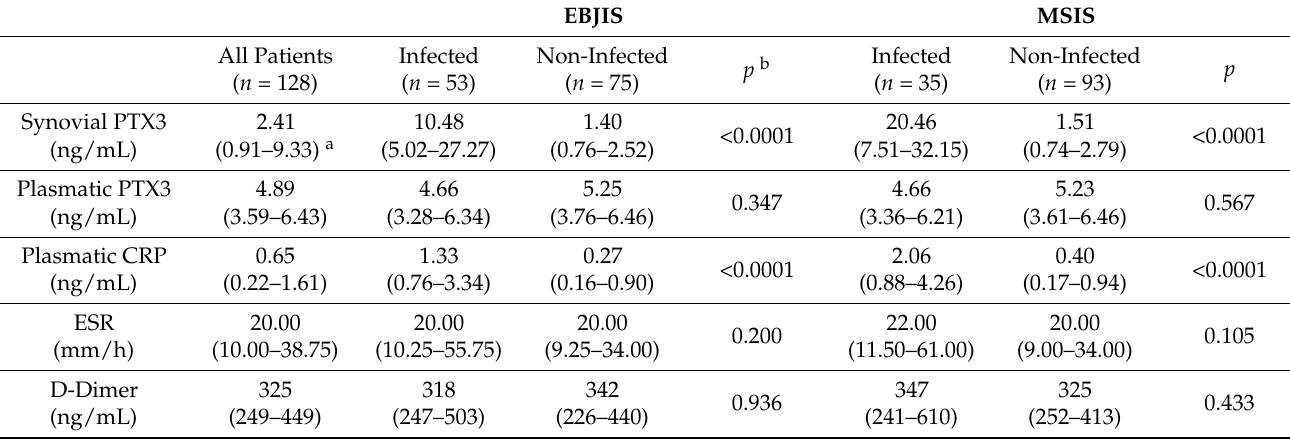
Table 4. Concentration of synovial and plasmatic